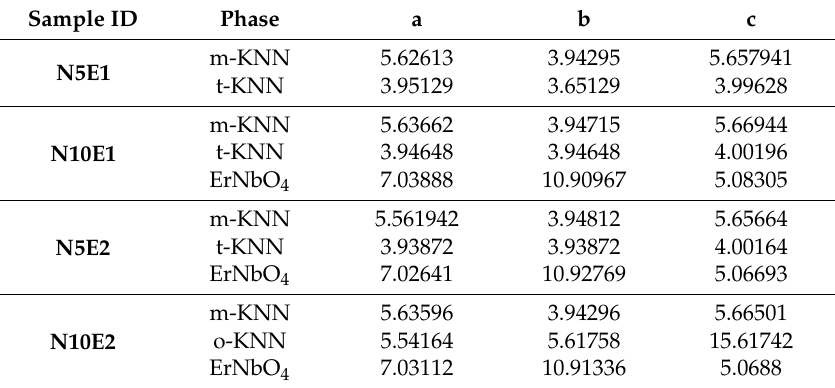
Figure 4. XRD patterns for all hot pressed samples with addition of Er2O3 and excess amount of Na2CO3 under 25 MPa of pressure for 2 h at 1100 ◦ C in argon flow with heating / cooling rate of 10 ◦ C / min and 8 ◦ C / min, respectively; ( a ) 1 wt.% of Er 2 O 3 and 5 wt.% of NaCO 3 excess, ( b ) 1 wt.% of Er 2 O 3 and 10 wt.% of NaCO 3 excess, ( c ) 2 wt.% of Er 2 O 3 and 5 wt.% of NaCO 3 excess, ( d ) 2 wt.% of Er 2 O 3 and 10 wt.% of NaCO 3 excess Table 4. Lattice parameters of phases detected by